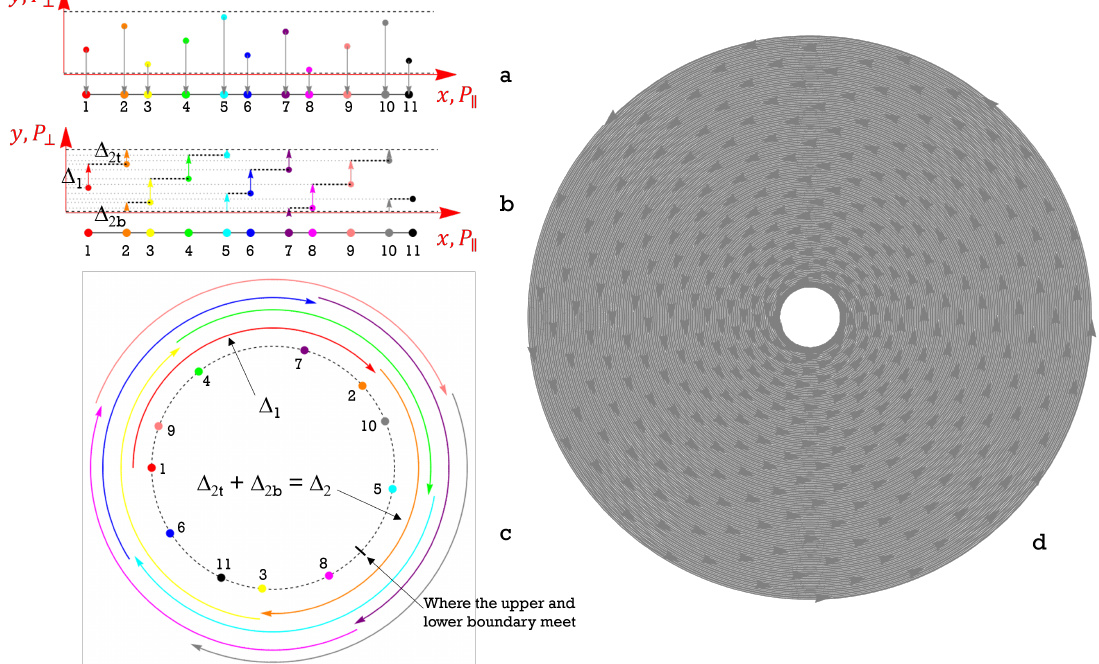
Figure 1. Cut-and-project scheme for Fibonacci chain. (a) Z 2 parent lattice with lattice vectors l 1 and l 2 , showing P , P , and cut region bounded by dashed lines. tan θ = Φ , the golden ratio. (b) Detail of parent lattice (rotated so P is horizontal) showing distances between points as projected in P k